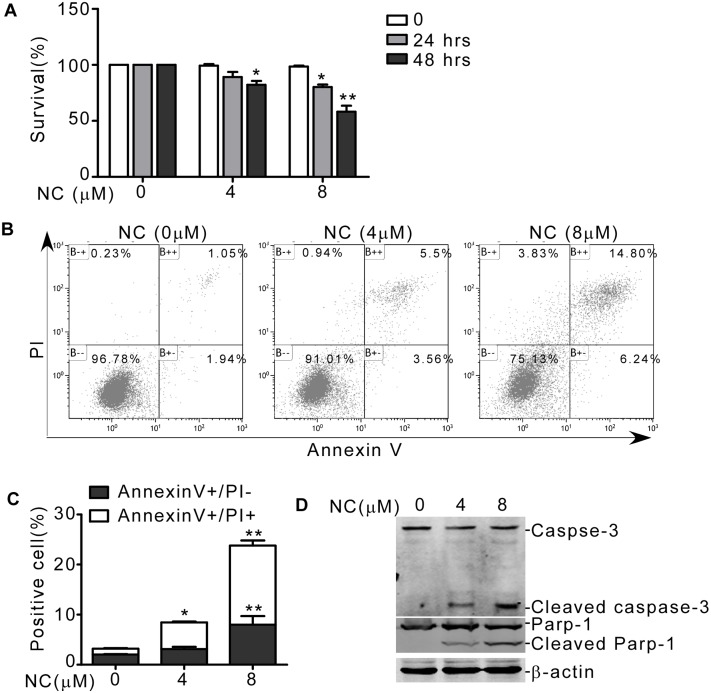
NC induced apoptosis in CML cells.(A) After K562 cells were treated with 4 or 8 μM NC for 24 or 48 hrs, MTT assay was performed to evaluate cell viability. The values represent the means ± S.E. (n = 3). *, P < 0.05. **, P<0.01. (B and C) After K562 cells were treated with 4 or 8 μM NC for 2 days, apoptosis rate was detected by annexin V/PI double staining. The values represent the means ± S.E. (n = 3). *, P< 0.05. **, P<0.01. (D) After K562 cells were treated with 4 or 8 μM NC for 2 days, cleaved caspese-3 and Parp-1 were detected by western blot.